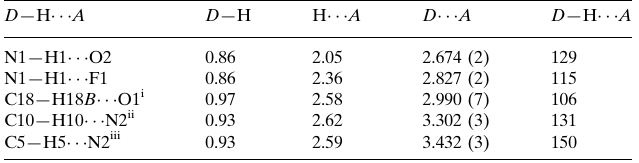
Hydrogen-bond geometry (A˚ , (cid:1)